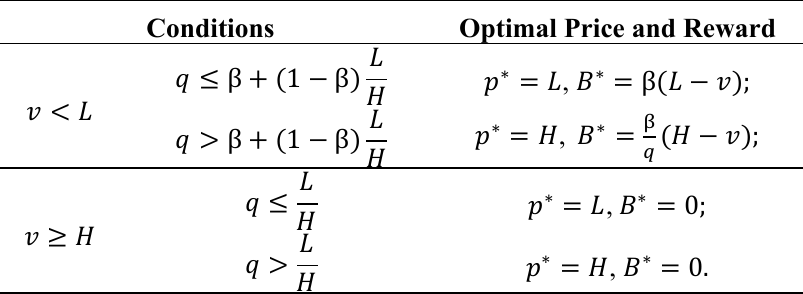
Table 2. Firm’s optimal strategies when (cid:1874) (cid:3407) (cid:1838) or (cid:1874) (cid:3410) (cid:1834)